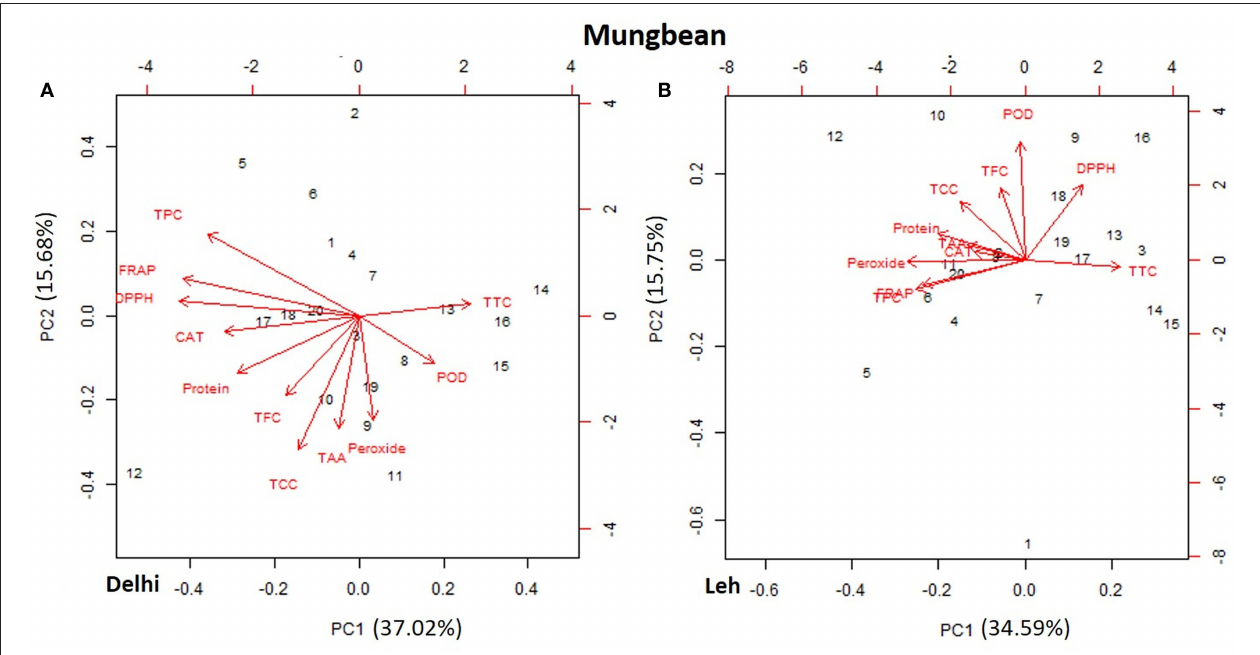
FIGURE 3 | Principal component plot derived from various antioxidant activities [1,1-diphenyl-2-picrylhydrazyl (DPPH), ferric-reducing antioxidant power (FRAP), peroxide, total carotenoids content (TCC), total tocopherol content (TTC), total ascorbic acid (TAA), peroxidase (POD), and catalase (CAT)], protein, phenolics TPC, and TFC in the mungbean microgreens when grown at (A) normal altitude (Delhi) and (B) high altitude (Leh) conditions.